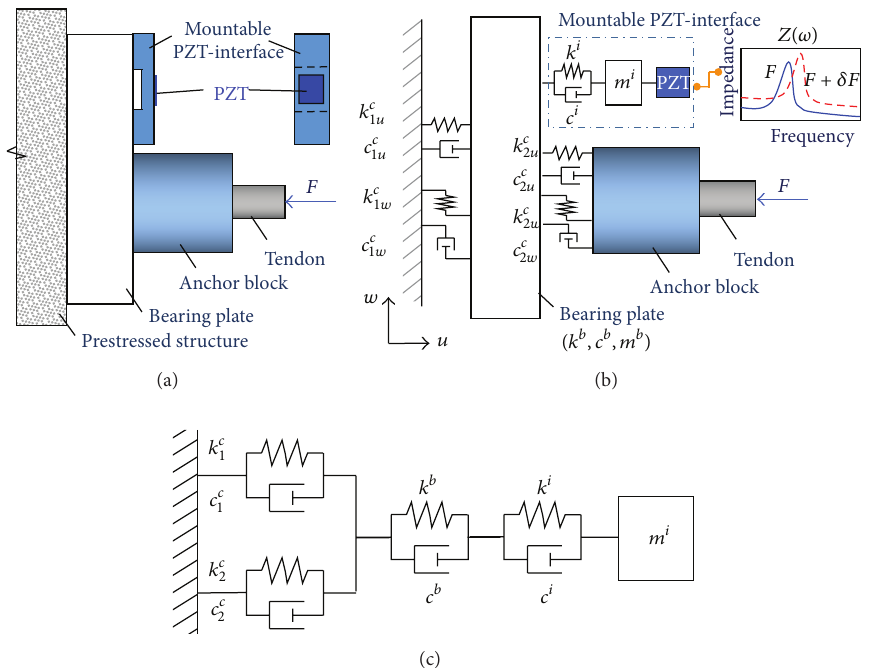
Figure 4: Structural model of tendon-anchorage with a mountable PZT-interface: (a) tendon-anchorage with PZT-interface; (b) analytical model; and (c) 1-dof